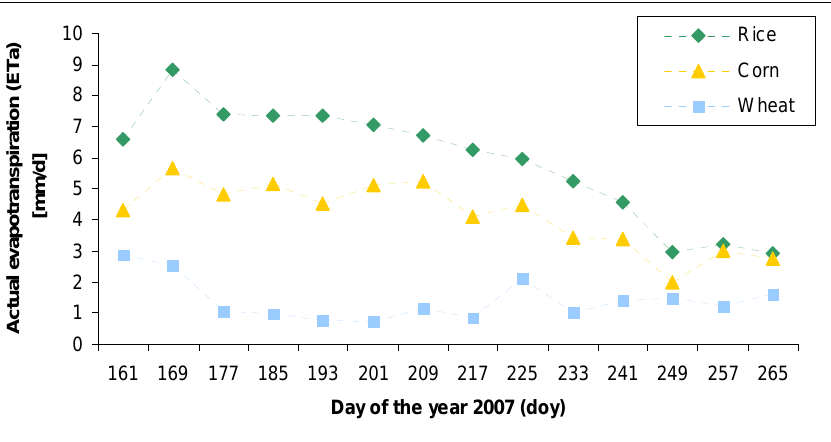
Figure 6. Temporal variation of ETa for irrigated rice and corn, and rain-fed wheat pixels from June to September